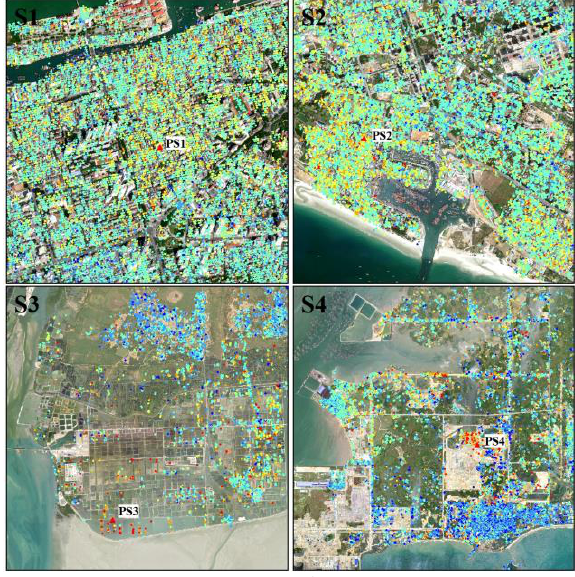
Figure 7. Subsidence of characteristic area The red triangle is the area where the timing points are